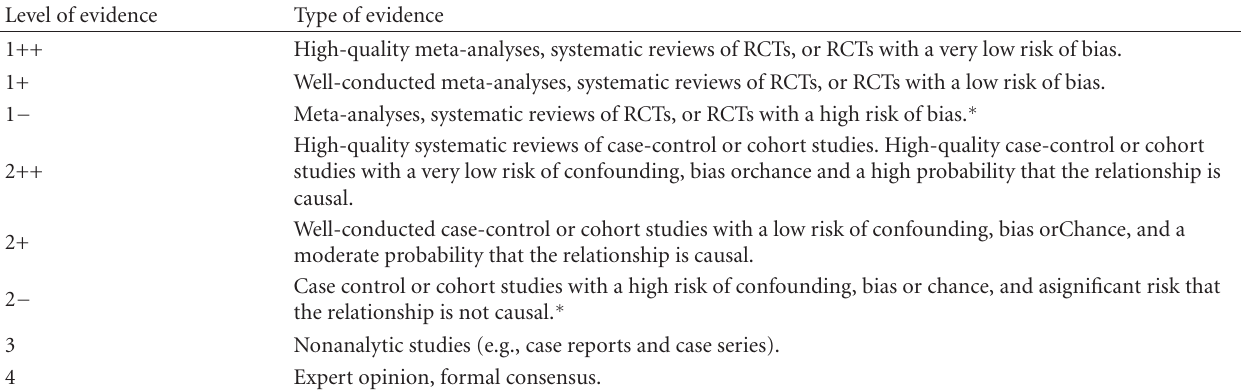
Table 4: Levels of evidence for intervention